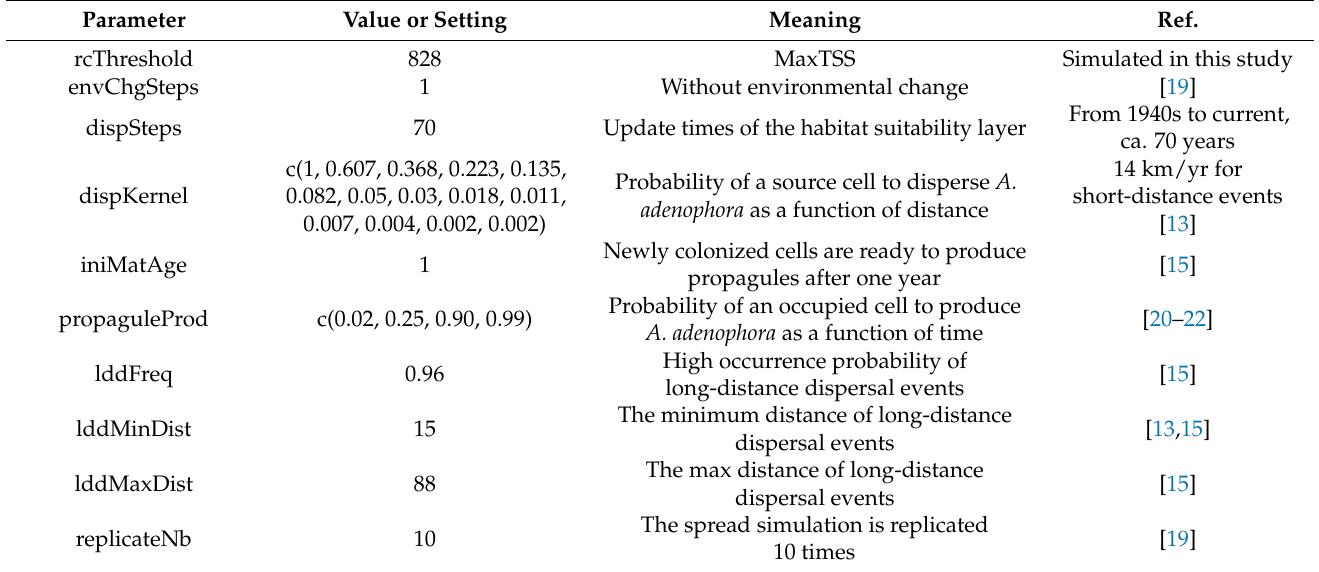
Table 2. Parameters used in the MigClim model for A.